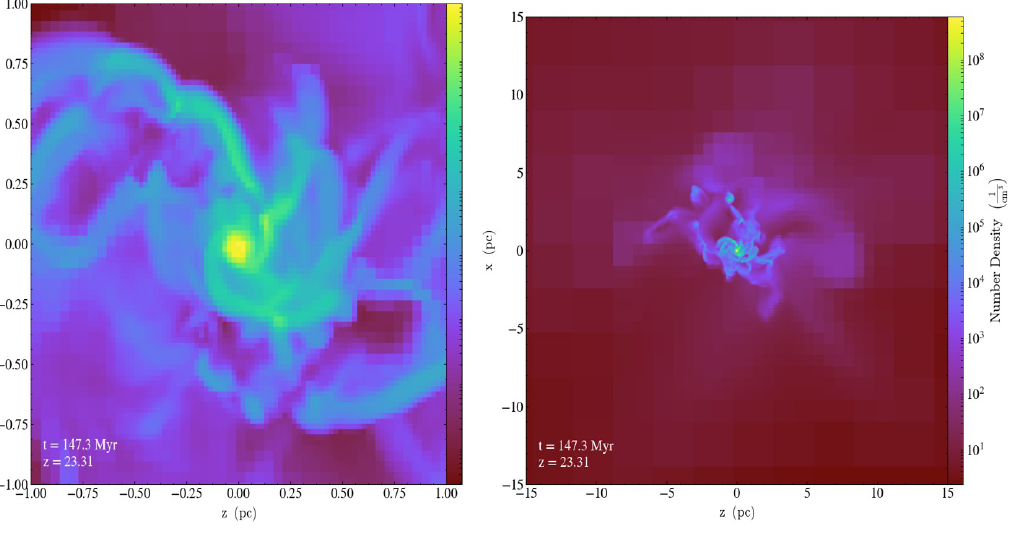
Figure 2. Formation of a protostar in a minihalo. The left figure shows a protostar in formation, while the left figure shows an accretion disk surrounding the protostar. These Figures are snapshots at the indicated time at the given